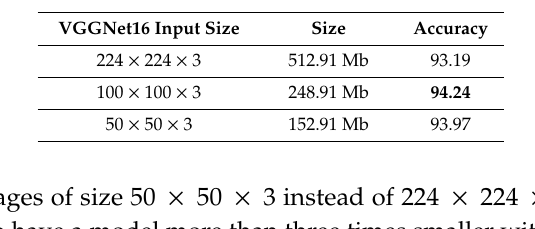
Table 12. Size of VGGNet16 with di ff erent sizes of the input image from the plant seedlings